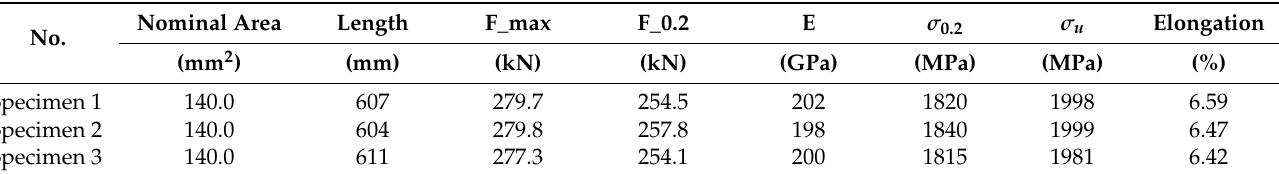
Figure 4. The recorded stress–strain curve of 1 × 7 steel strand according to code GB/T 288.1 B30 [35]. Table 2. Test parameters and material properties.